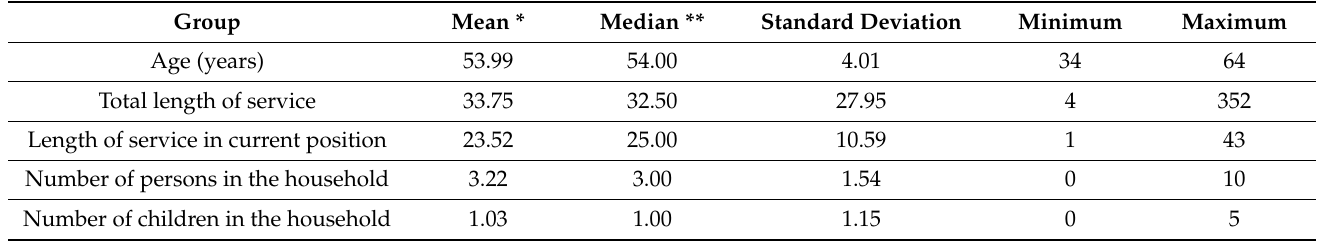
Table 2. Results of Part A of the Psychosocial Risk Scale questionnaire.